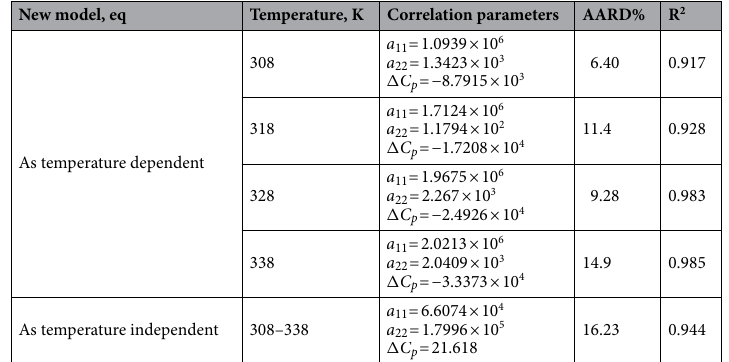
Table 3. Correlation constants of the new model.